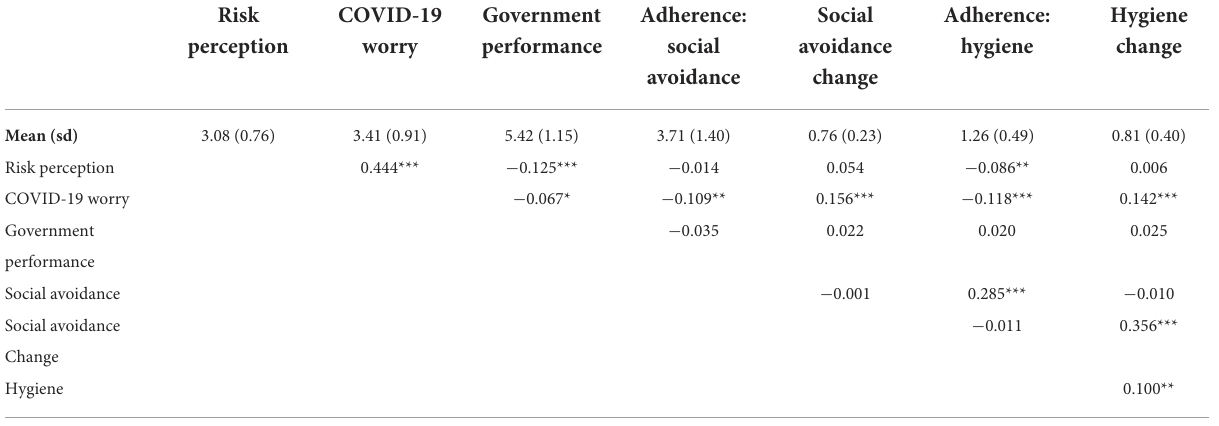
TABLE 1 Mean (standard deviation) and correlations between variables of interest.